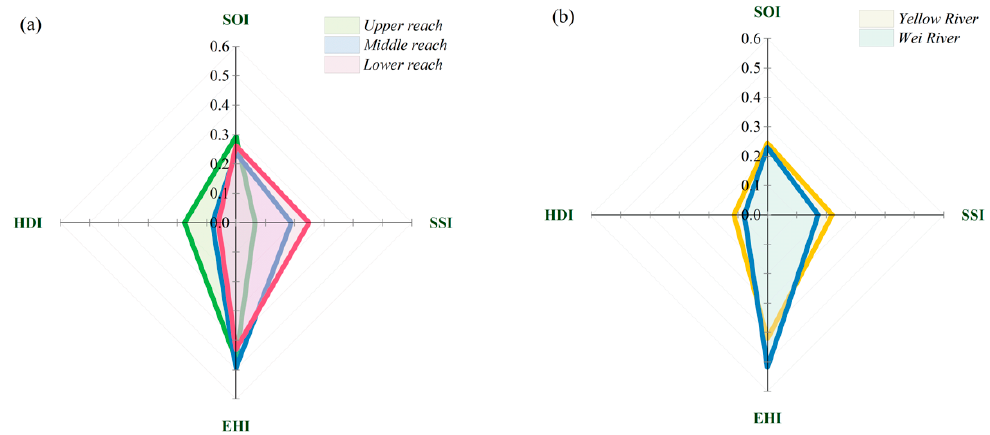
Figure 8. The degrees of limitation to the Happy River Index posed by the four dimensions: ( a ) at a river-reach scale of the Yellow River, and ( b ) at the mainstem scale.